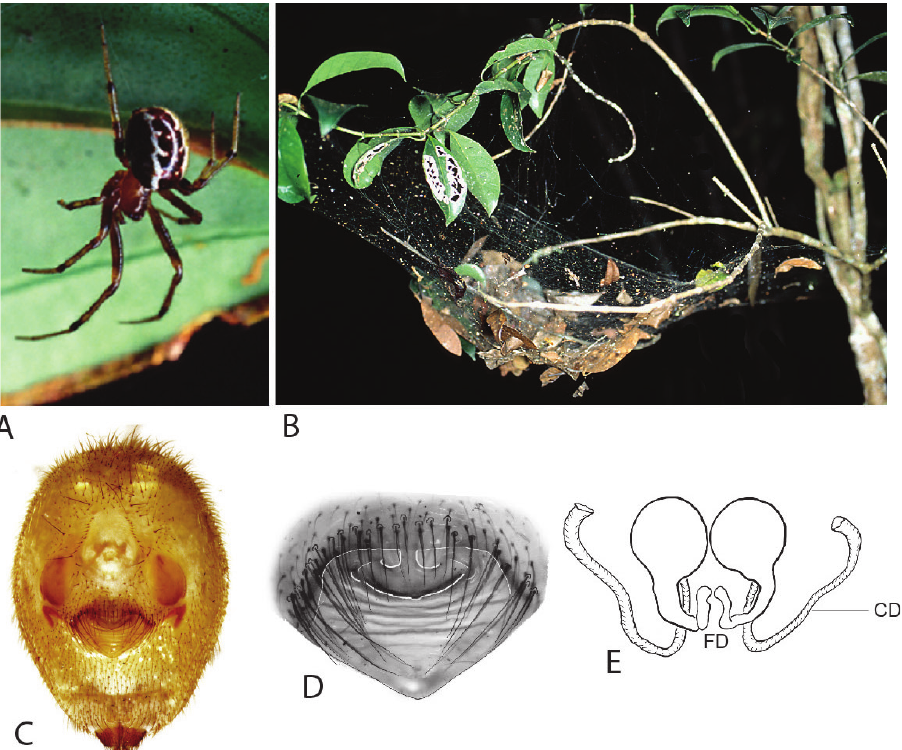
Figure 11. Anelosimus ata : A–B female and her web C female abdominal venter D epigynum, ventral E epigynum, dorsal. Images are schematic and not to